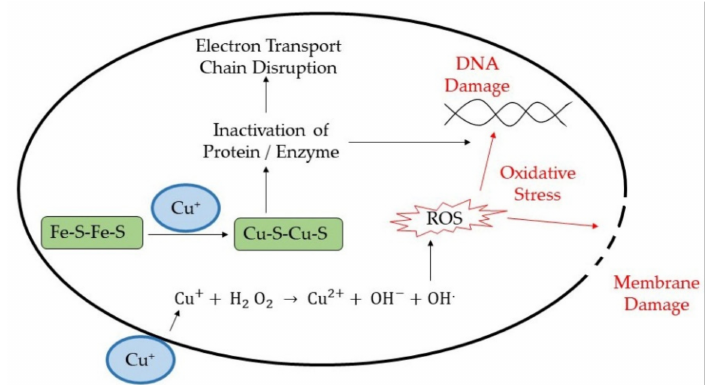
Figure 6. Antimicrobial mechanism of copper ions through ROS production and metal donor atom